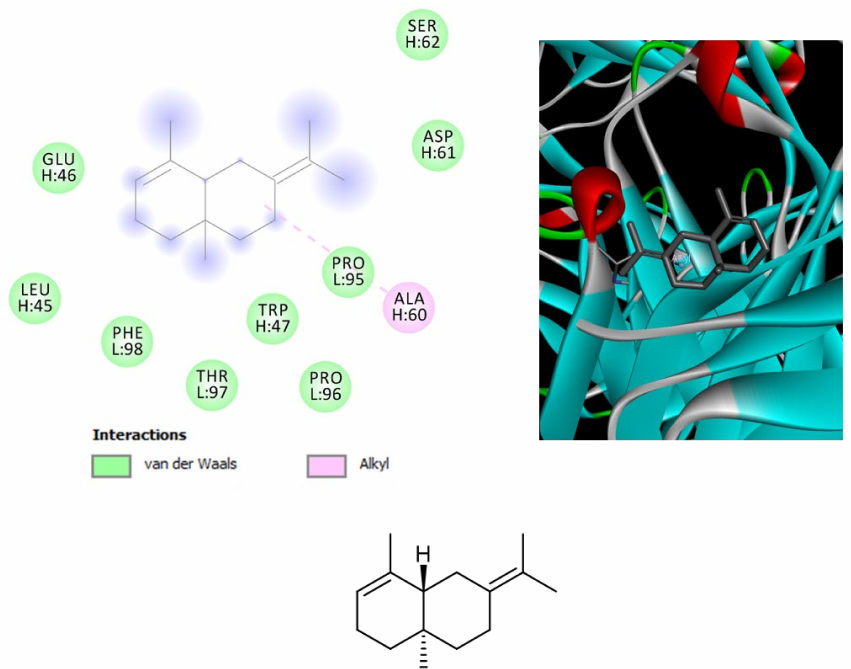
Figure 4. Structure and in silico interactions between selina-3,7(11)-diene and cannabinoid CB2 receptor (CB2; PDB: 2HFF). Free energy of binding ( ∆ G) and affinity (Ki) are − 6.2 kcal/mol and 28.9 µ M, respectively.